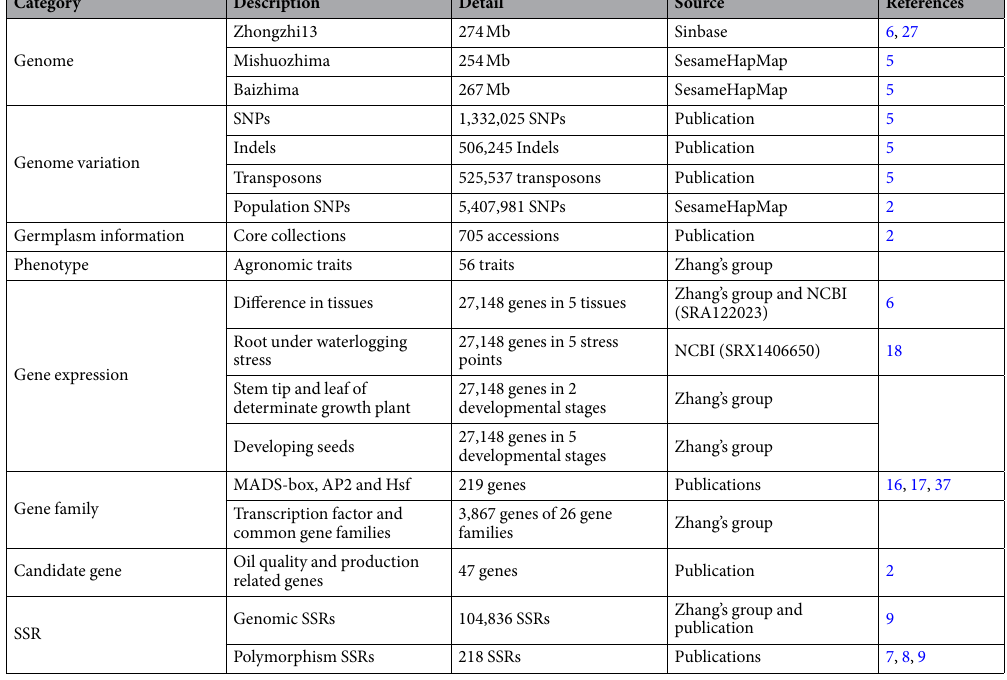
Table 1. Summary of the data